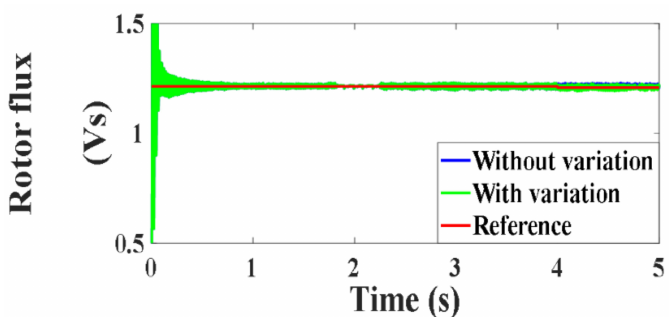
Figure 70. Rotor flux under PVC